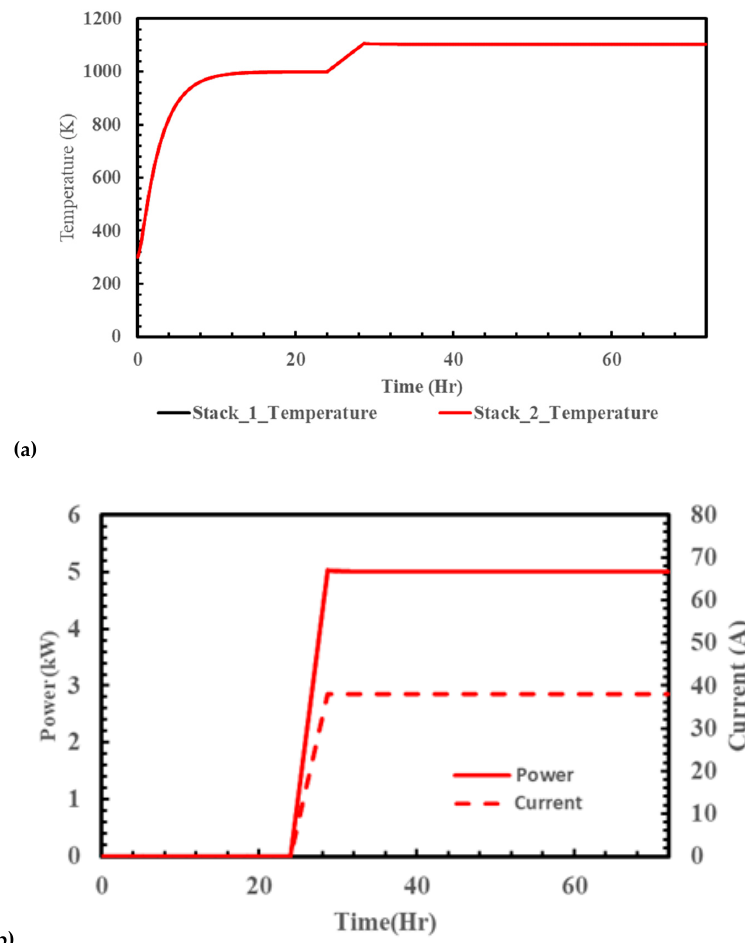
Figure 4. The dynamic curves of ( a ) the stack temperature and ( b ) the operating power and current of the two-stack SOFC system with an equal flow split ratio. the two-stack SOFC system with an equal flow split